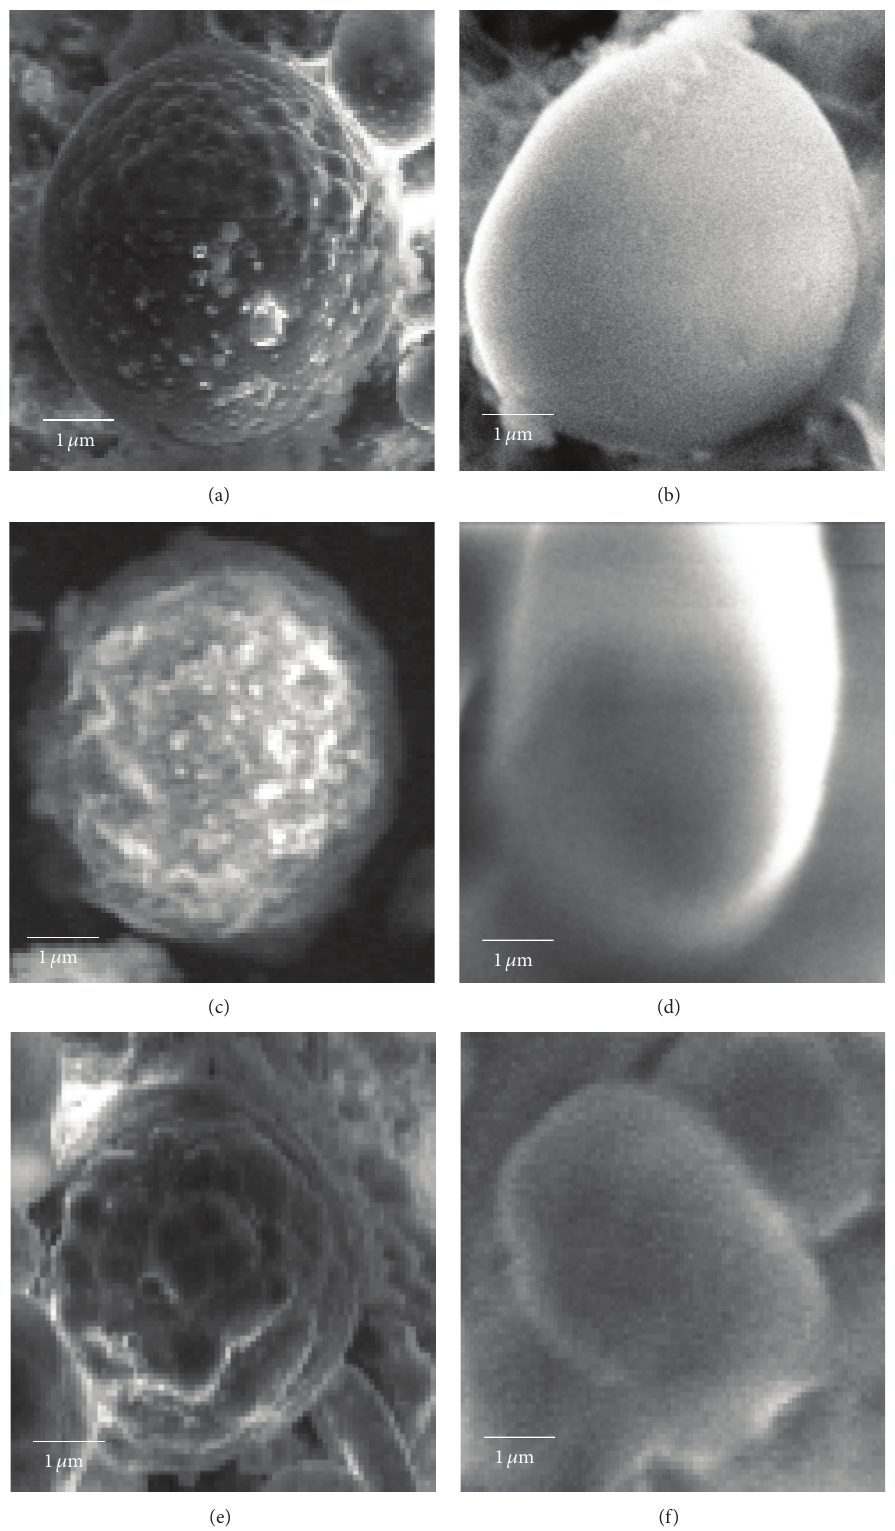
Figure1:Scanningelectronmicroscopyofmicroparticles.(a)PLGA :A1(85 :15),(b)PLGA:A2(85 : 15),(c)PLGA: A1(75: 25),(d)PLGA:A2 (75 :25), (e) PLGA:A1 (50: 50), and (f) PLGA:A2 (50